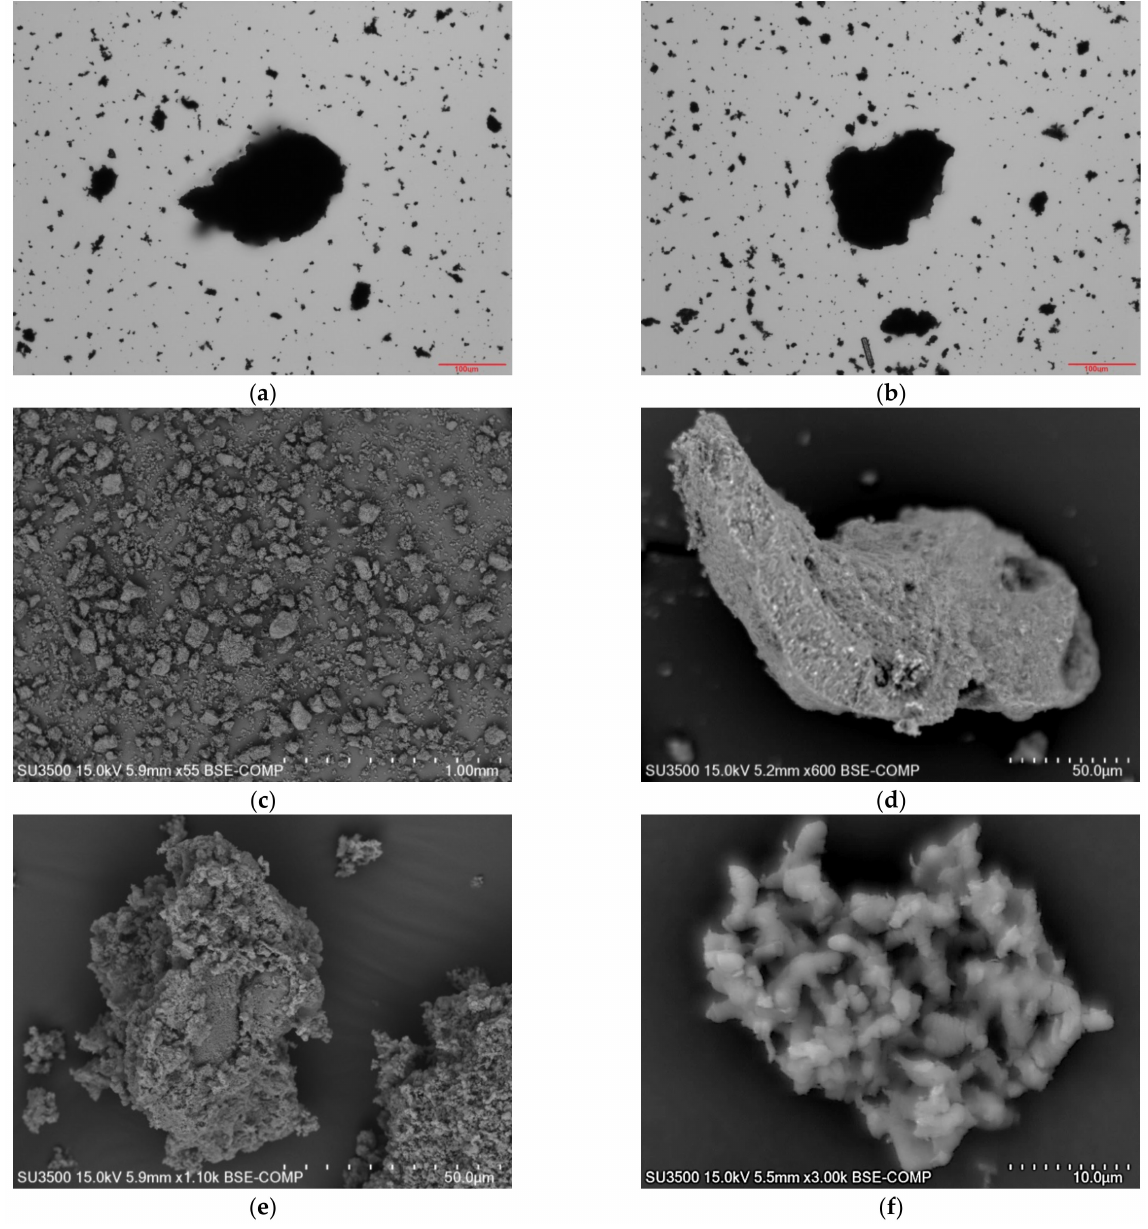
Figure 1. Images of selected grains for ash (sample PMA): ( a , b ) optical images; ( c – f ) SEM